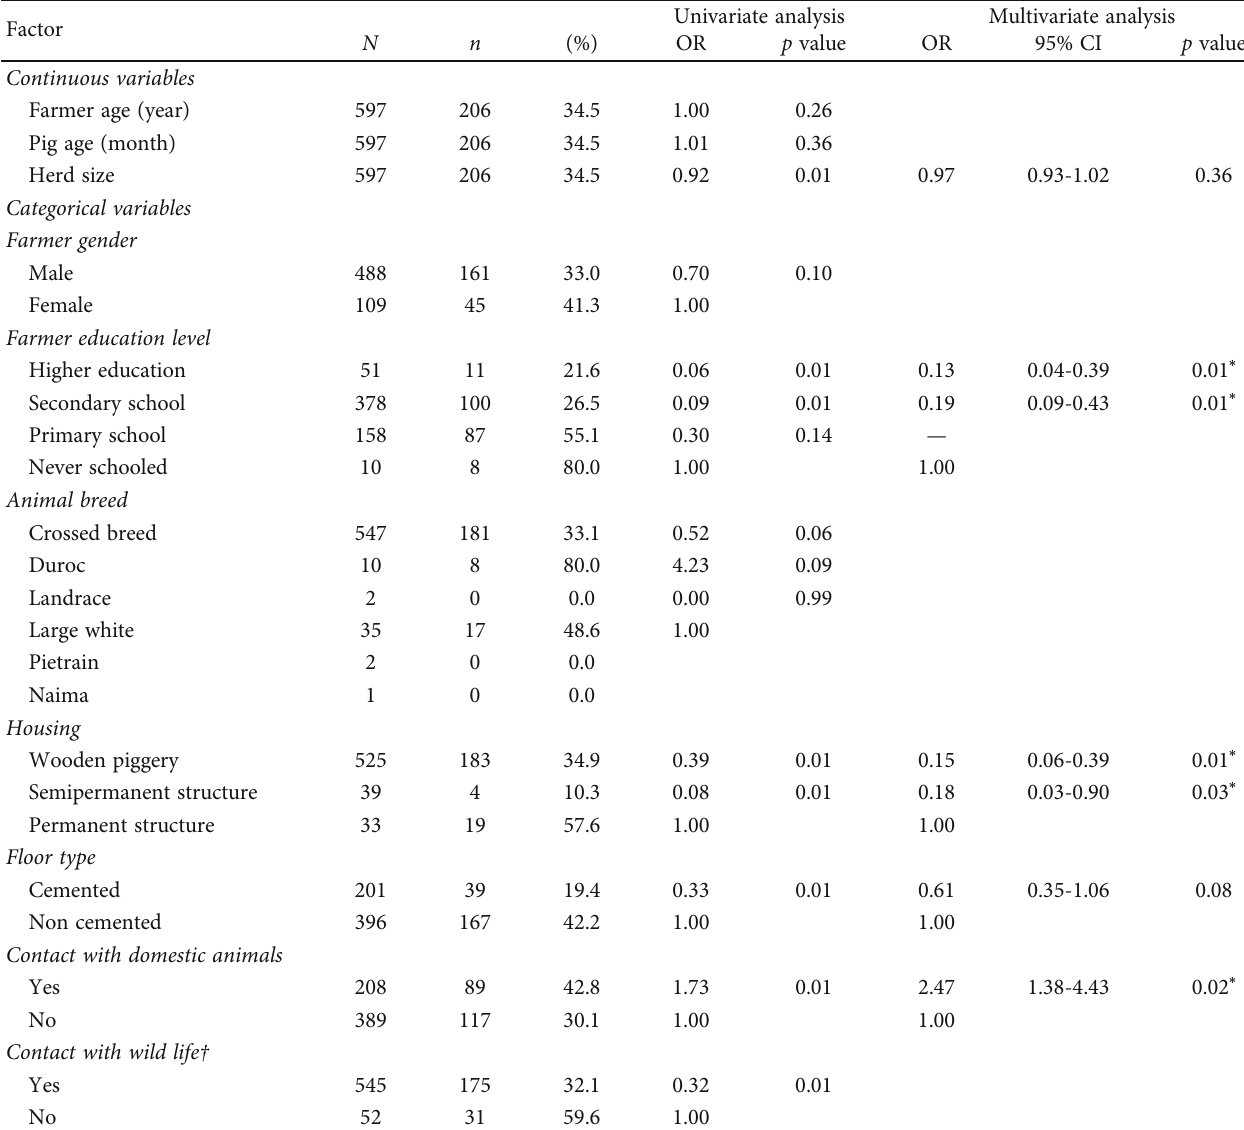
Table 4: Logistic regression analysis of risk factors for Strongyloides ransomi infection in pig farms in Menoua Division. Results are expressed in terms of odd ratio (OR) and 95% con fi dence interval